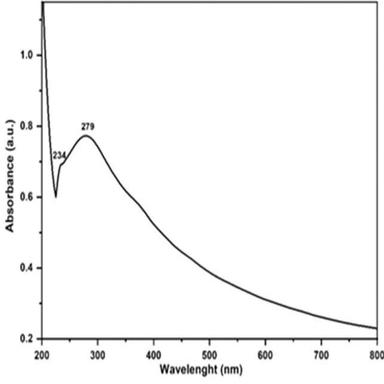
UV− vis absorption spectrum of MTZ - ZnMoO4 nanocomposite.